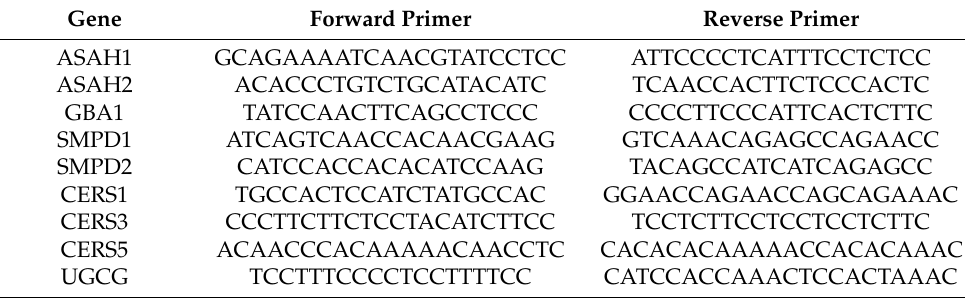
Table 1. List of primers used for real-time PCR.